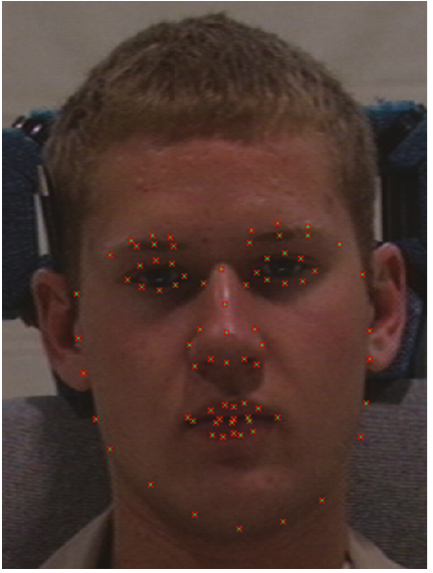
Figure 11: The 79 keypoints that parameterizes the active shape model for a given